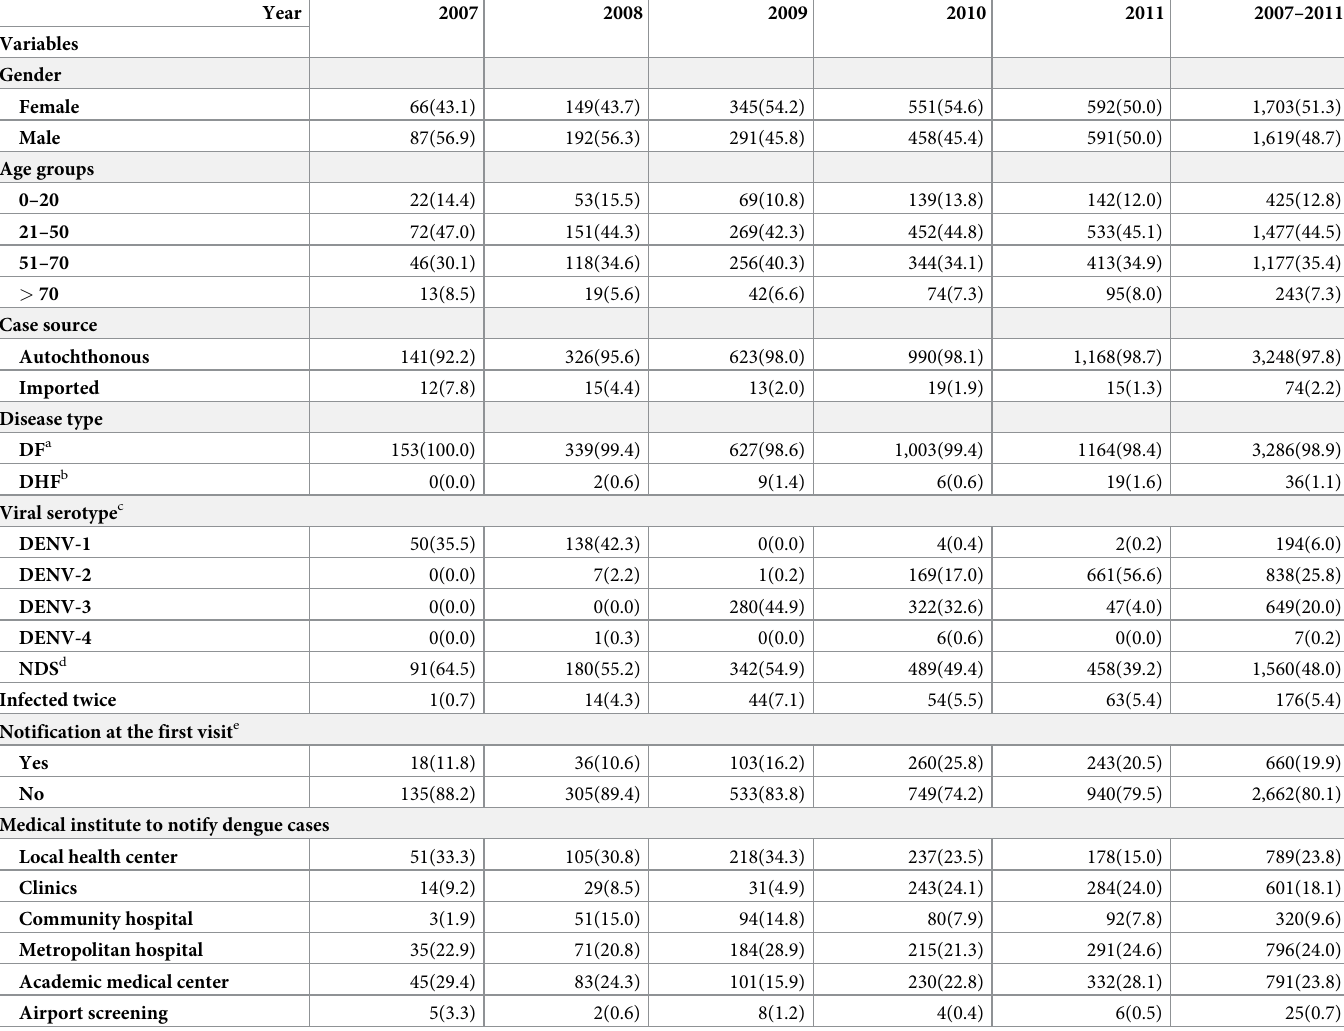
Table 1. Demographic and epidemiological characteristics of dengue-infected patients (N =